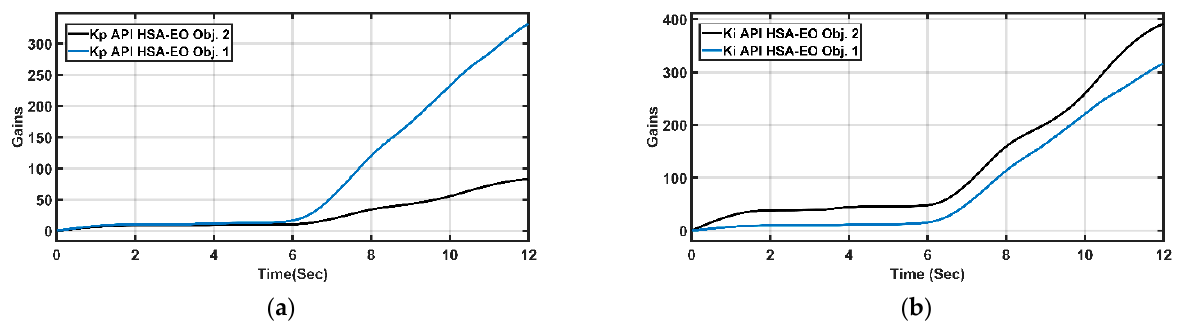
Figure 33. ( a ) (cid:1837) (cid:3043) adaptive PI gain of faulty third case. ( b ) (cid:1837) (cid:3036) adaptive PI gain of faulty third case. Figure 33. ( a ) K p adaptive PI gain of faulty third case. ( b ) K i adaptive PI gain of faulty third Table 15. Numerical comparison between the controllers at faulty third case.